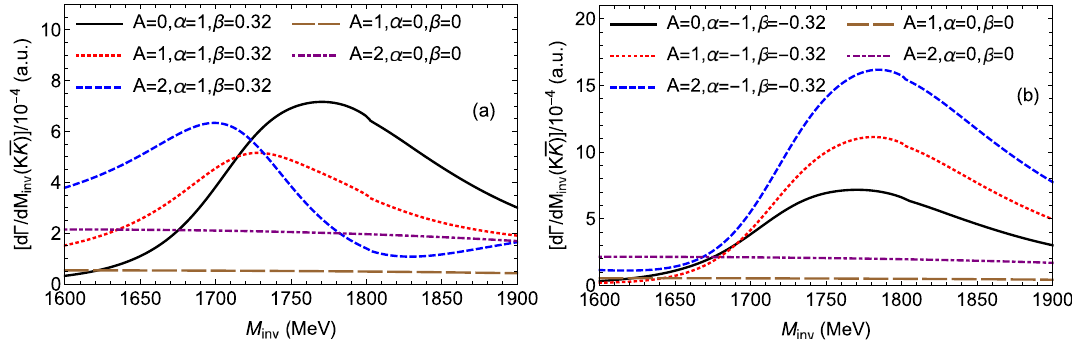
Fig. 6 a Squared modulus of triangle loop integrals V K ∗+ K ∗− , j and V V K ∗+ K ∗− , j and V , including the widths of the vector kaons. We have factorized the factor g 2 present in Eq. (29) K ∗ 0 ¯ K ∗ 0 , j